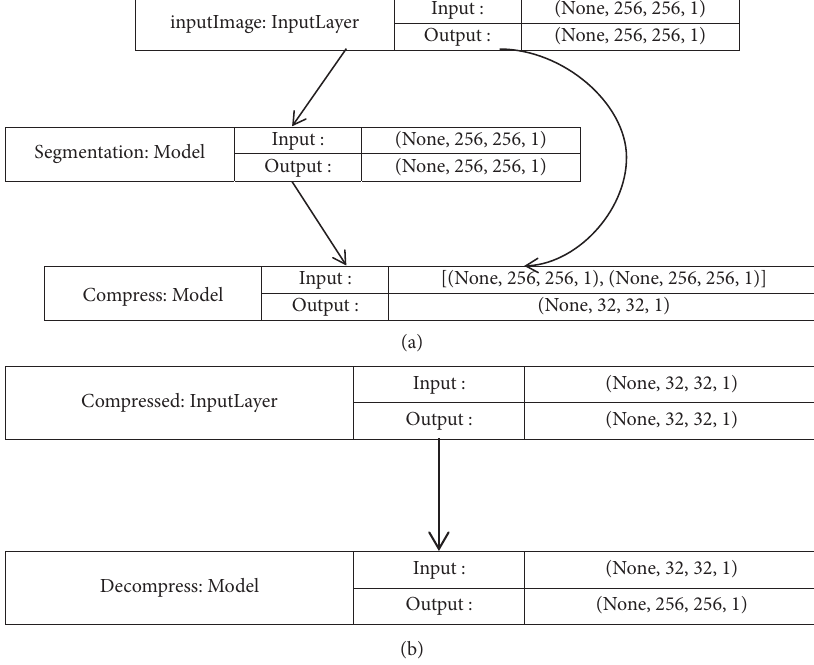
Figure 3: Decomposed neural networks. (a) Compression; (b) decompression. Table 1: A number of selected images in each category. Number of